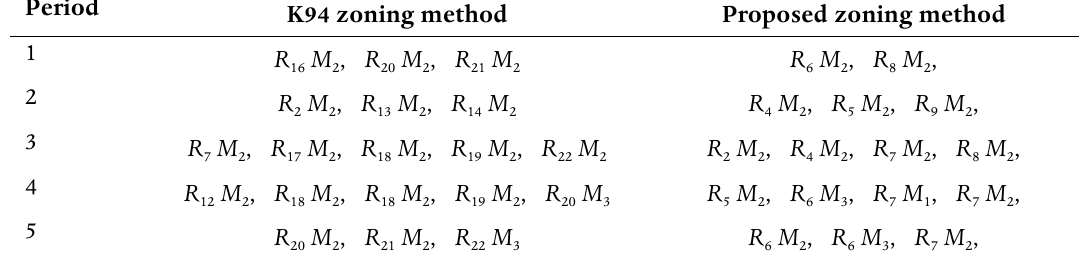
Table 5. Actual earthquake occurrences during the following 5 time periods after the last earthquake